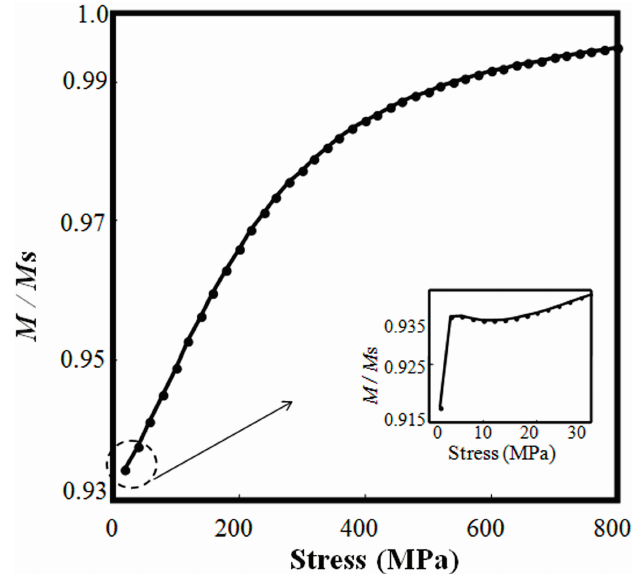
Figure 3. The simulated relationship of magnetization and stress with H = 15 kA/m.